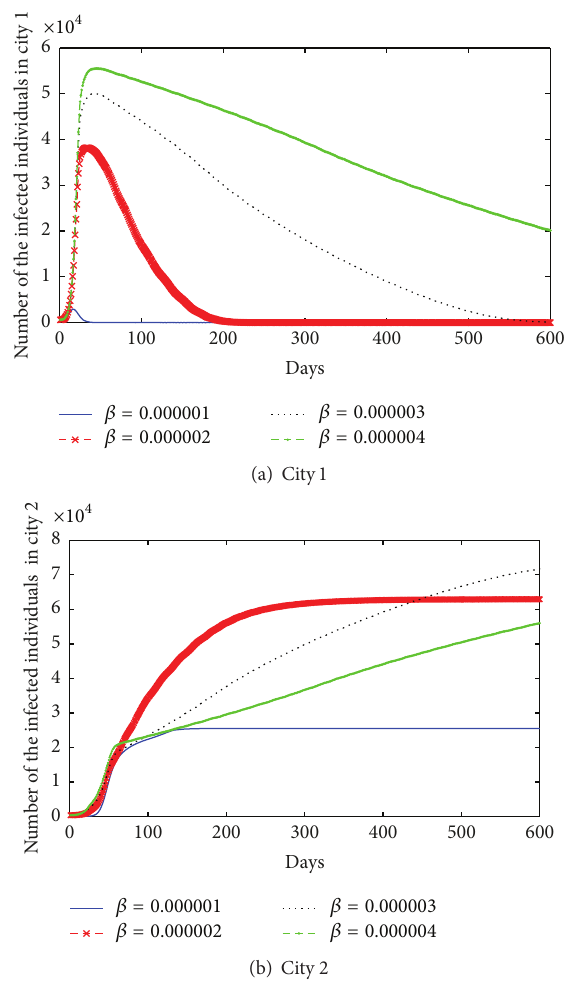
Figure 3: Number of the infected individuals versus different 𝛽